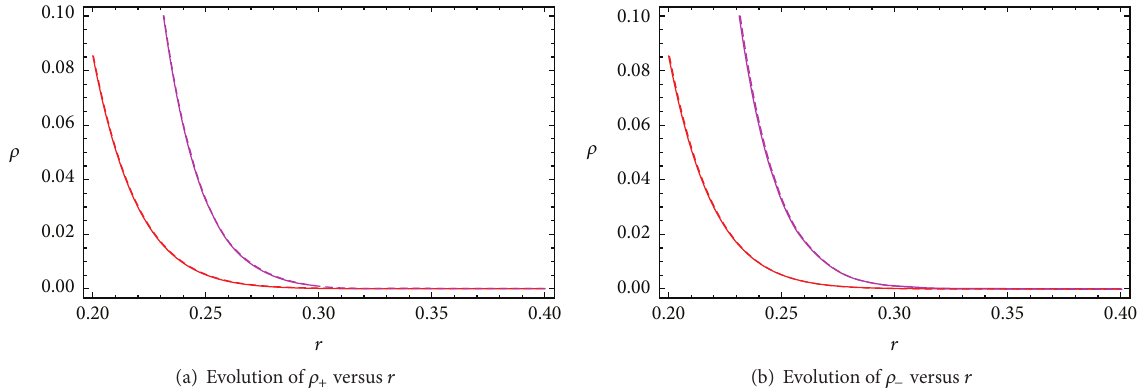
Figure 2: Plots of (a) 𝜌 + and (b) 𝜌 − versus 𝑟 in Gaussian distribution for 𝑛 = 5 , 𝜖 = 1 (red), 𝑛 = 5 , 𝜖 = −1 (red dashed), 𝑛 = 6 , 𝜖 = 3 (purple), and 𝑛 = 6 , 𝜖 = −3 (purple